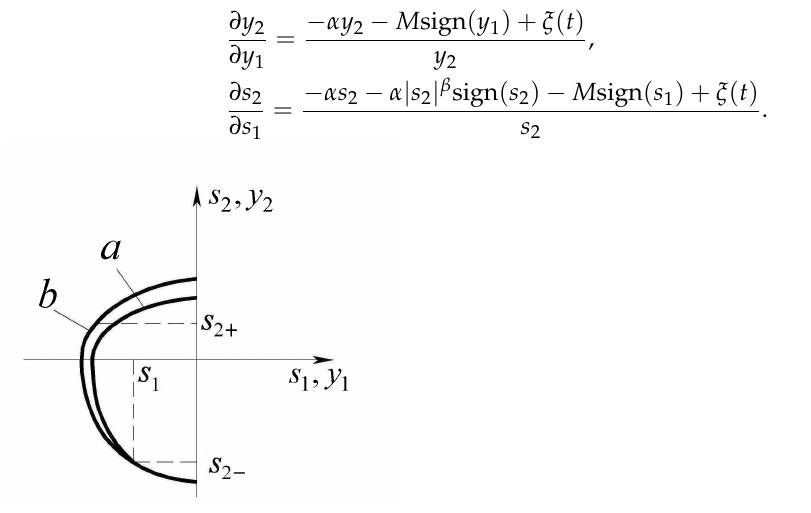
Figure 1. Phase portraits of systems (8), (14) and